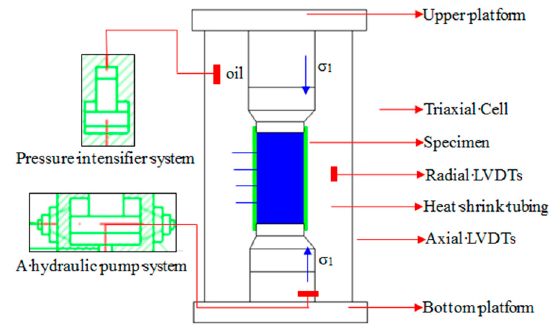
Figure 4. Schematic diagram of the MTS test machine structure.